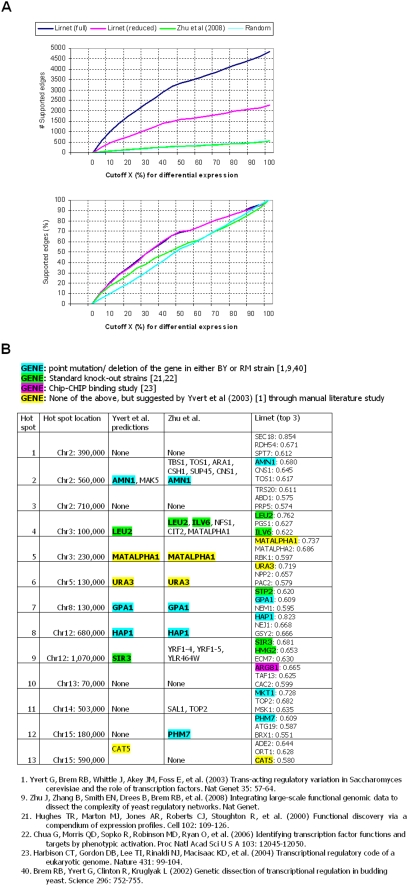
Evaluation of the learned network in comparison to results of Zhu et al. [9].We compared two versions of Lirnet results with the learned network of Zhu et al: all 10,565 regulator-target pairs from the regulatory network (‘full’ in the graph legend); 3,645 top-ranked pairs, in terms of the magnitude of the weight, to provide a comparable number of predictions to the network of Zhu et al (‘reduced’ in the graph legend). We evaluated support for these sets of edges in the gene expression data of [21],[22]. Here, a pair r-t for a regulator r and target t is considered supported if t is in the top X% of differentially expressed genes in response to a knockout or over-expression of R. (A) Shows the cumulative distribution of the number of computational predictions that receive support for different values of X (top). As a baseline, we also show the number of validated predictions expected in a random regulatory network. Not all regulators were tested in the microarray data. To avoid possible biases, we also compare the fraction of validated predictions among all predictions that were tested (bottom). We see that Lirnet selects many more tested predictions than the method of Zhu et al., but also has a much higher fraction of validated predictions, even when we focus only on tested predictions. (B) Candidate causal regulators for 13 chromosomal regions identified in a previous study. For the 13 hot spots previously suggested [1], we applied our approach to compute the regulatory potential to prioritize the candidate genes in each region. The first four columns are from the paper by Zhu et al [9]. For each hot spot, we present the causal regulators suggested by: the original paper of [1]; the method of Zhu et al, and the top 3 Lirnet regulators, ranked by their regulatory potentials (see Methods). The causal regulators that have some support (see Methods) are colored accordingly (see legend). Of the top Lirnet regulators, 14 regulators, spanning 11 hot spots, have experimental support, in comparison to 8 regulators (7 hot spots) in the analysis of Zhu et al. Even if we consider only Lirnet's top regulator for each region, there is experimental support for 10 regulators (in 10 hot spots). The results of the previous method (first four columns) are from Table 3 of Zhu et al [9], except for the indication of the supported regulators.